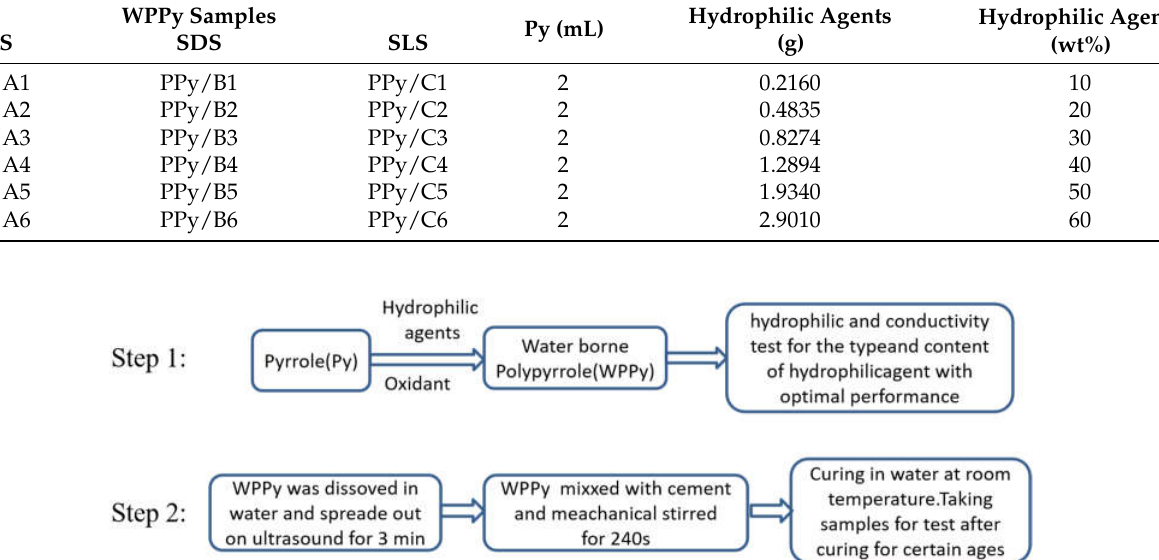
Table 1. Polymerization formulas.